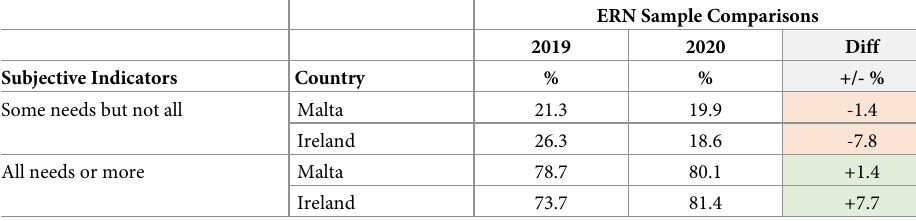
Table 6. Response rate comparison of subjective economic well-being across ERN events in 2019 &